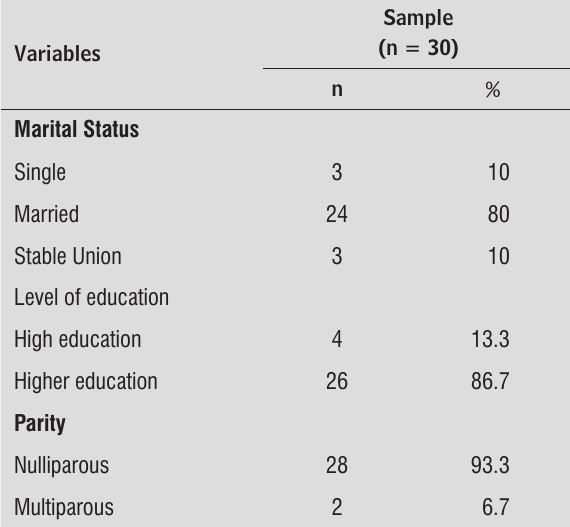
Table 1 - Sociodemographic and obstetric characteristics of the sample